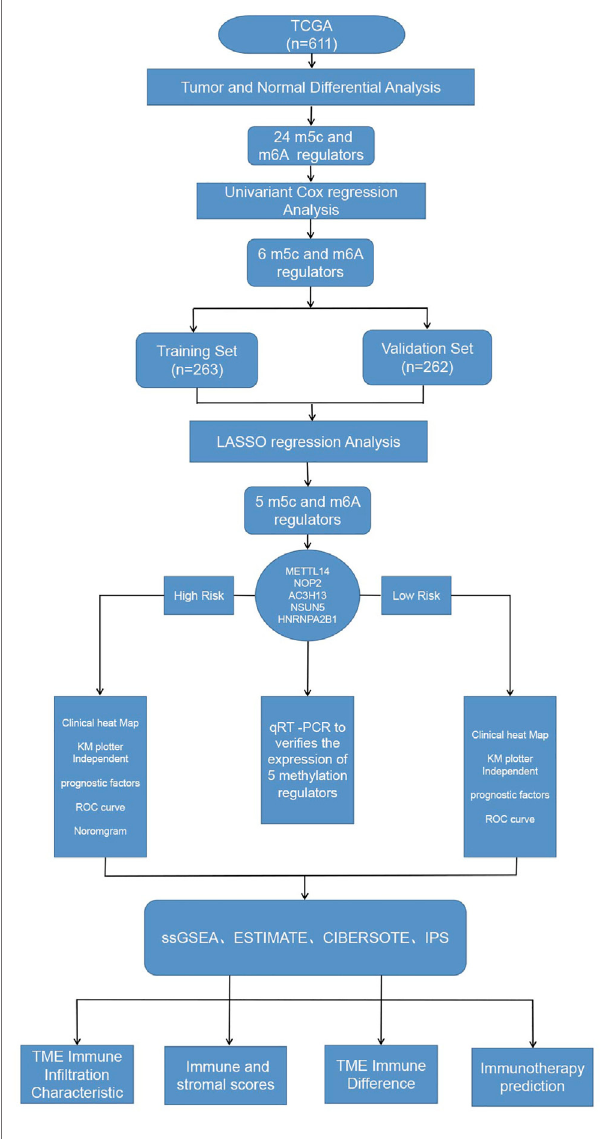
FIGURE 1 | Work fl ow of this study.